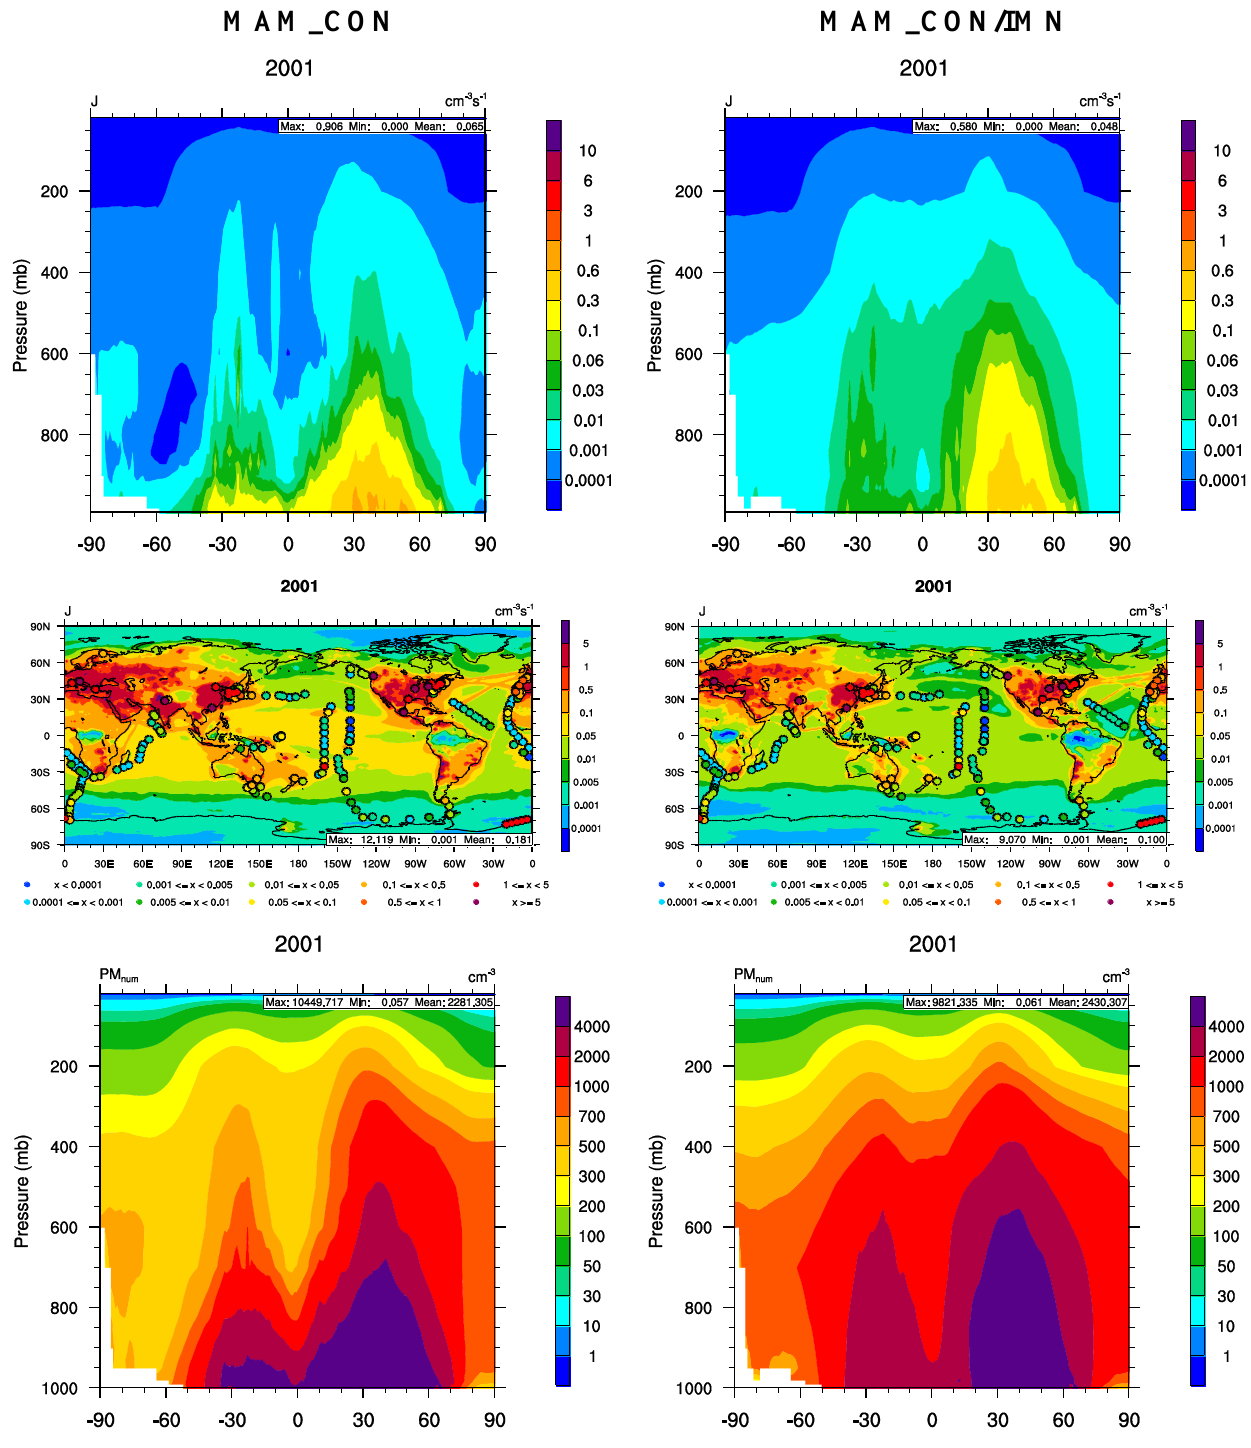
Figure 4. Vertical distributions of new particle formation rate ( J ) (row 1) and aerosol number (PM num ) (row 3) simulated by MAM_CON/IMN for 2001. The overlay plots in row 2 show the distributions of simulated and observed J in the bottom 1000m of the atmosphere. Circles on overlay plots represent observations for J . Different colors of circles represent different values of J , using the same color scale as simulated J.